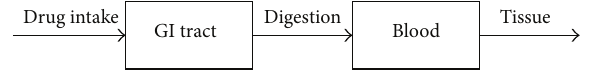
Figure 1: Schematic of input/output compartment for drug assimi-